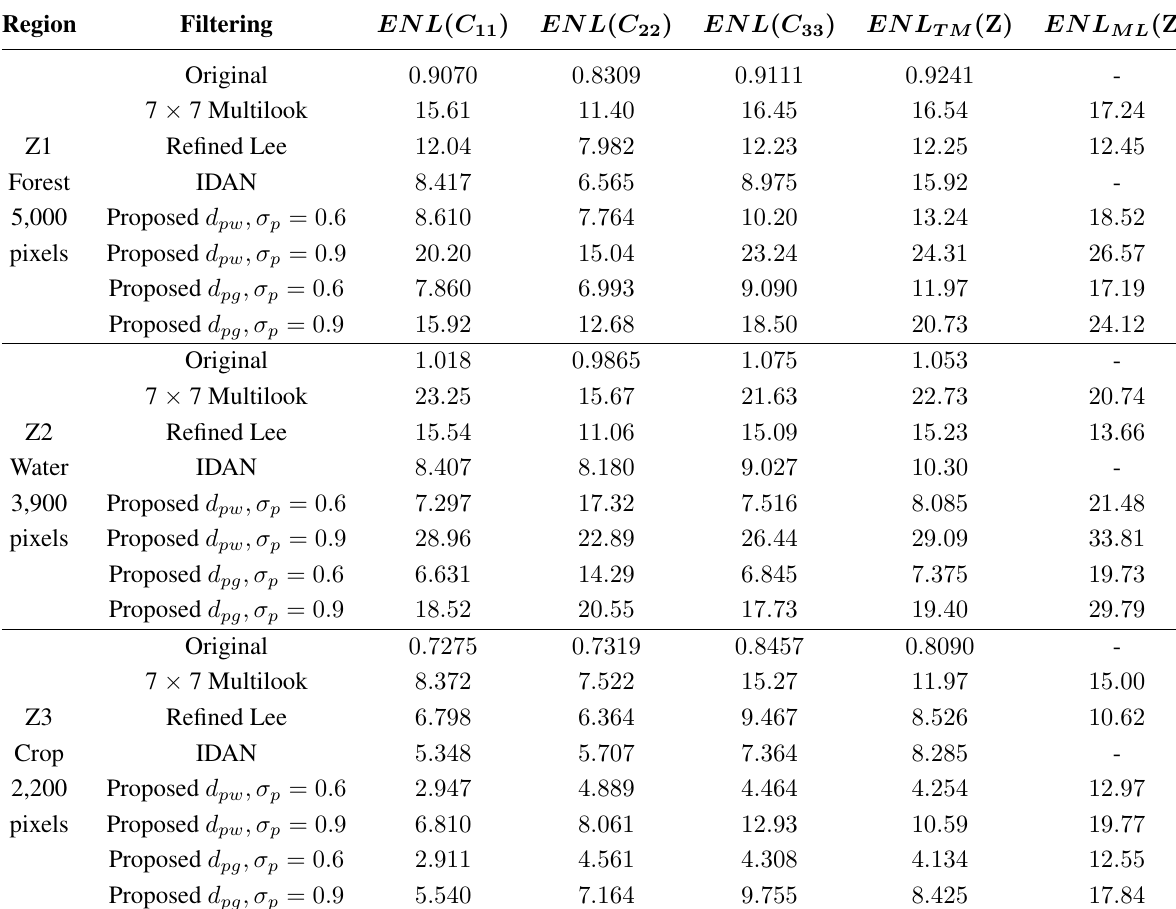
Table 2. Estimated equivalent number of looks (ENL) for different filtering techniques. For the proposed technique, an 11 × 11 local window has been employed with 5 weight = 3 refinement iterations and σ s